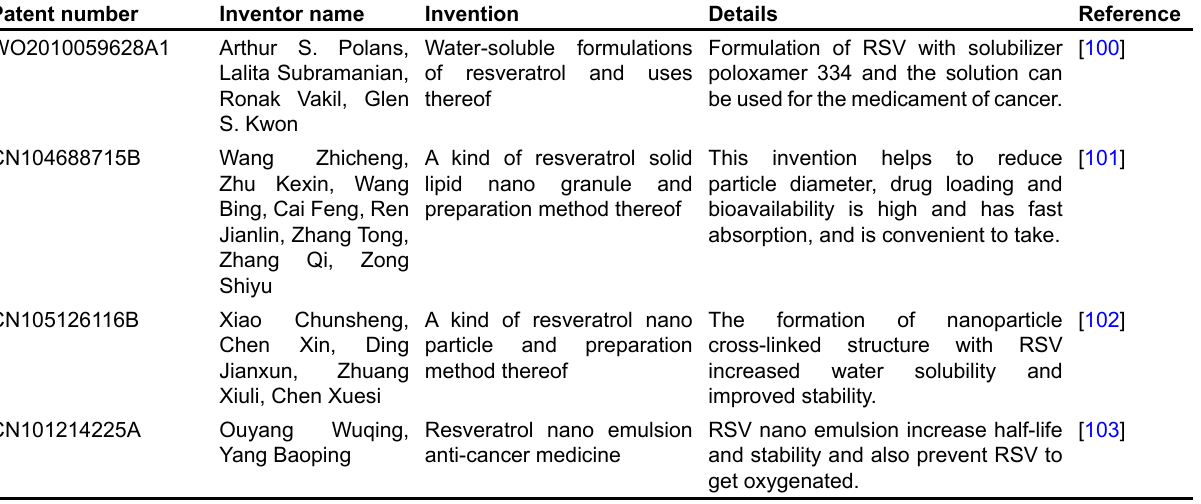
Table 2. Patent survey of different nano-formulations of RSV ( continued